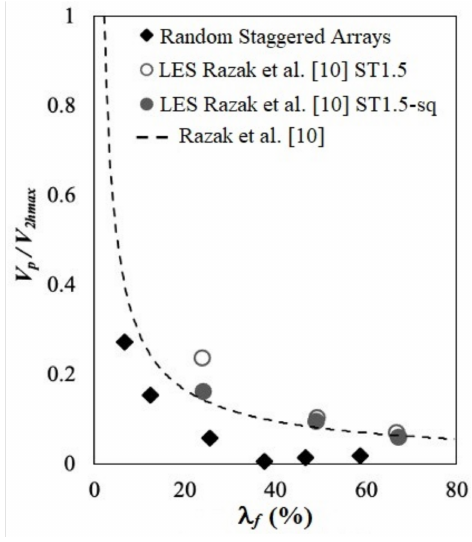
Figure 6. Relationship between V p /V 2hmax and the frontal area density, λ f for the random staggered arrays from the LES database [23], compared with the results of Razak et al.